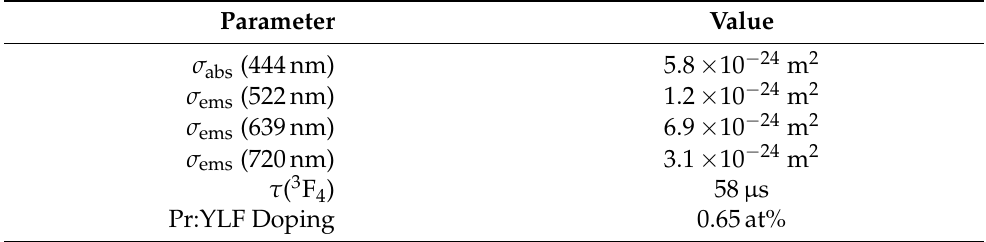
Table A1. Parameters used for the simulation of the population densities in Praseodymium doped nanothermometers all values are according to the cited literature